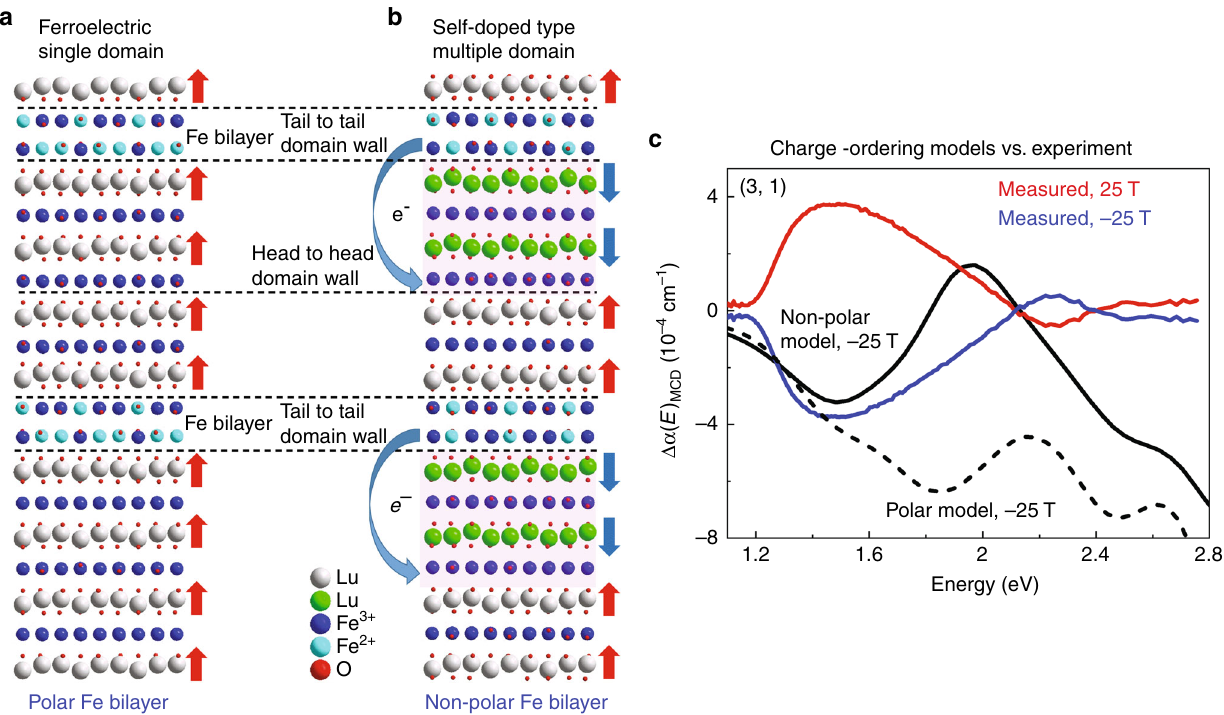
Fig. 4 Candidate charge-ordering patterns for (LuFeO 3 ) 3 /(LuFe 2 O 4 ) 1 and comparison of calculated vs. measured dichroic spectra. a Ferroelectric single-domain type (CO-FE) charge-ordered state with a polar Fe bilayer. The Lu-layer displacement is symmetric, and red arrows indicate the polarization direction. b Self-doped-type (CO-DOPED) multi-domain charge-ordered state with a nonpolar Fe bilayer, unveiling spontaneous electron transfer from the Fe bilayers to the LuFeO 3 layers. The polarization changes direction across the domain boundaries (dashed lines) as shown by the red and blue net dipole arrows, and the Lu-layer displacement is asymmetric with both down/up/up and down/up/down Lu distortion patterns surrounding the Fe double layer. c Experimental dichroic spectra Δ α ( E ) MCD along with calculated Δ α ( E ) MCD of the CO-FE (polar Fe bilayer) and CO-DOPED (nonpolar Fe bilayer) charge- ordering states in the (3, 1)